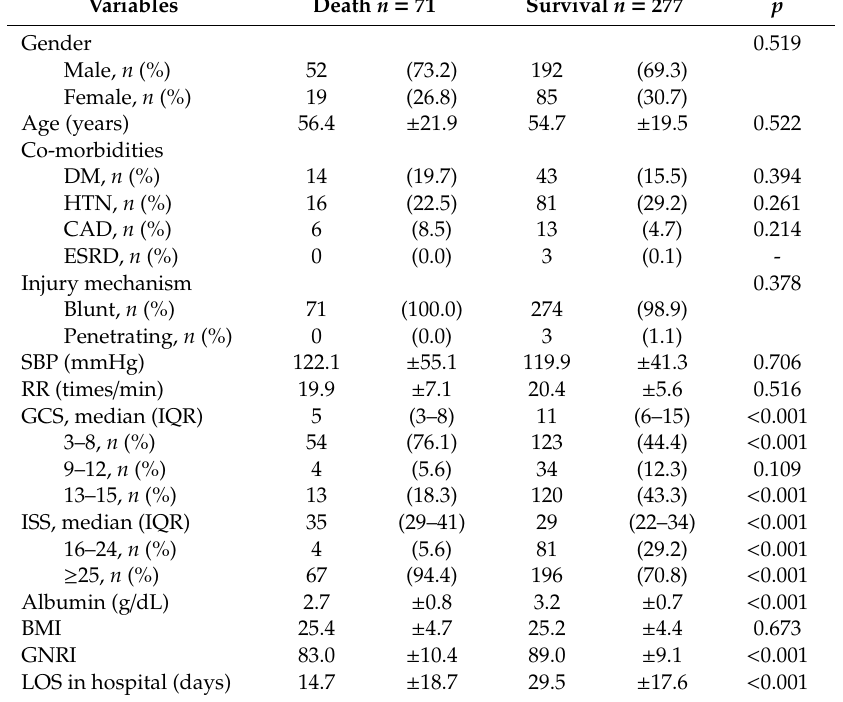
Table 1. Patient and injury characteristics of the death and survival groups of adult patients with